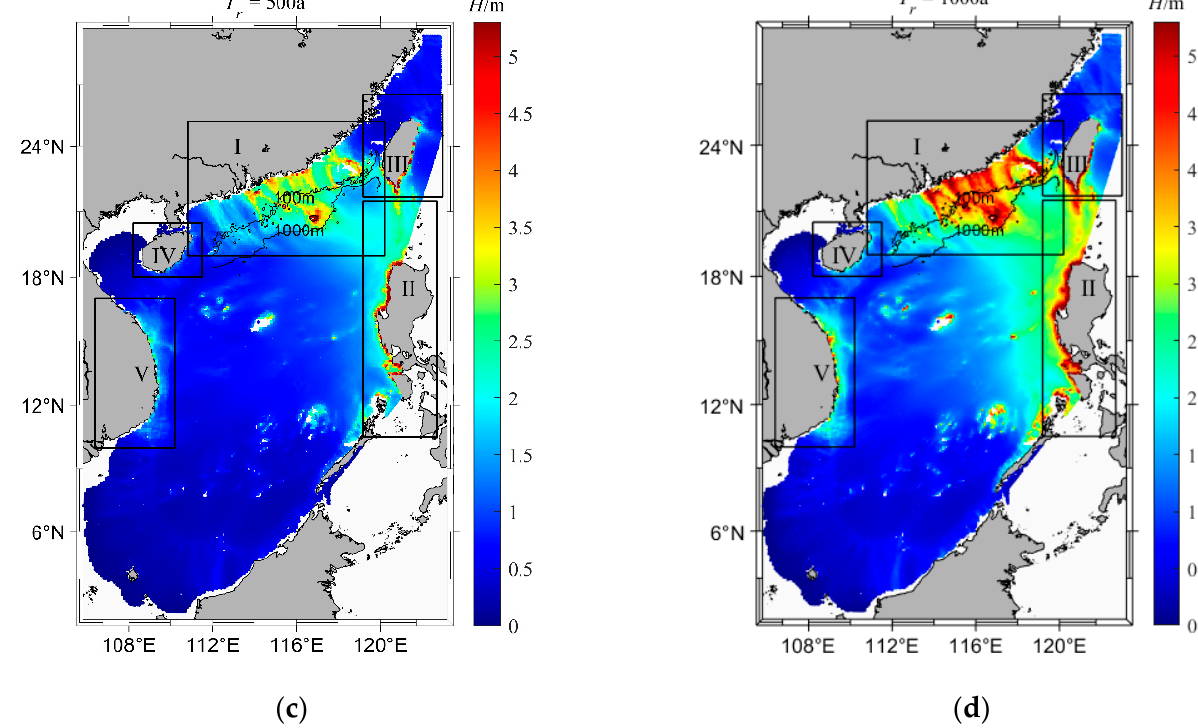
Figure 5. The spatial distribution of wave height ( H ) when return period T r = 100a, 200a, 500a and 1000a. The isobaths of 100 m and 1000 m are marked in the figure. ( a ) T r = 100a, ( b ) T r = 200a, ( c ) T r = 500a, ( d ) T r = 1000a.